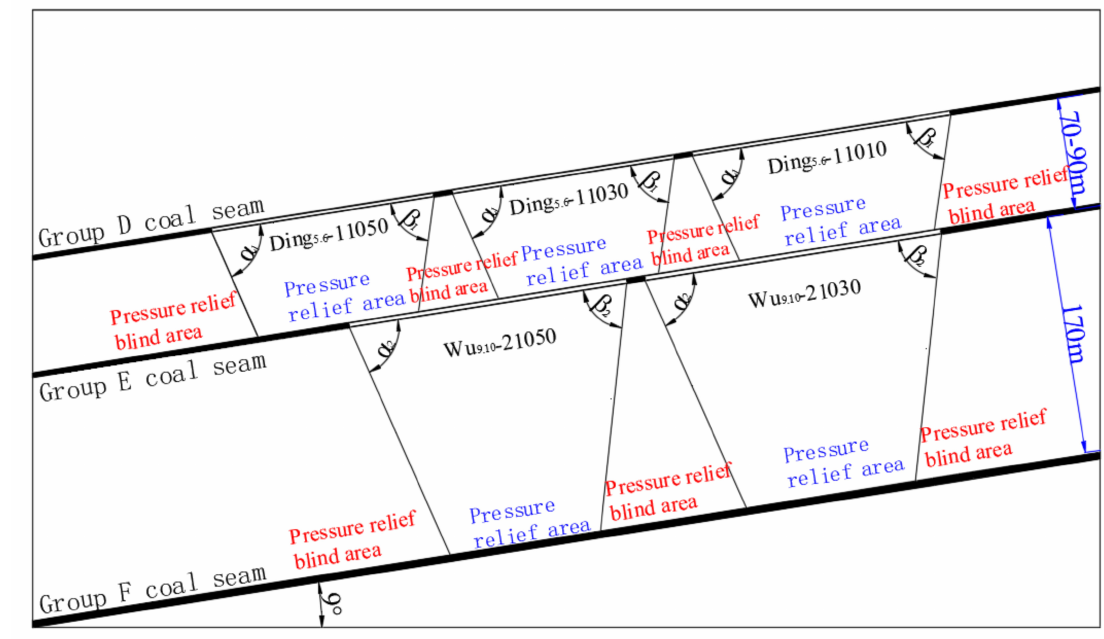
Figure 11. Model pressure-relief